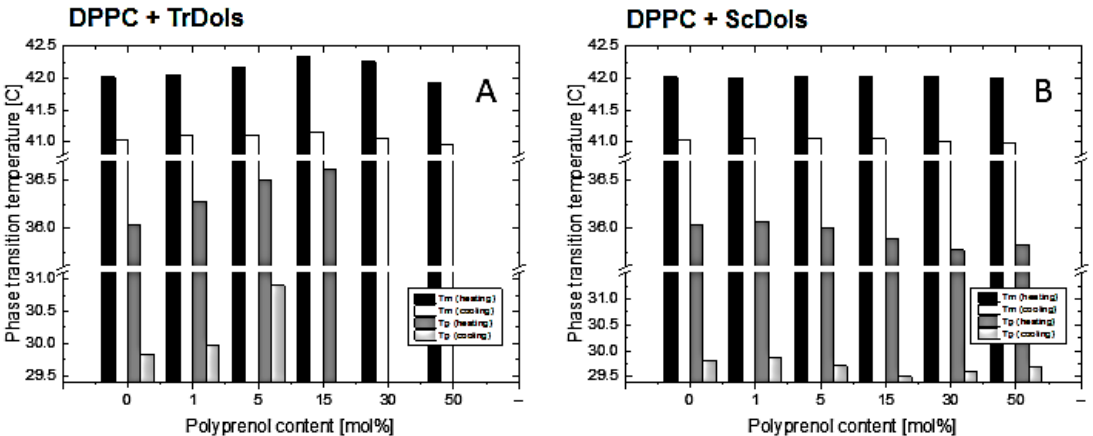
Figure 8. Influence of concentration of dolichol on phase transition temperature of DPPC membranes. Phase transition temperature of DPPC multilamellar vesicles obtained in the cooling and heating modes for TrDols ( A ) and ScDols ( B ).